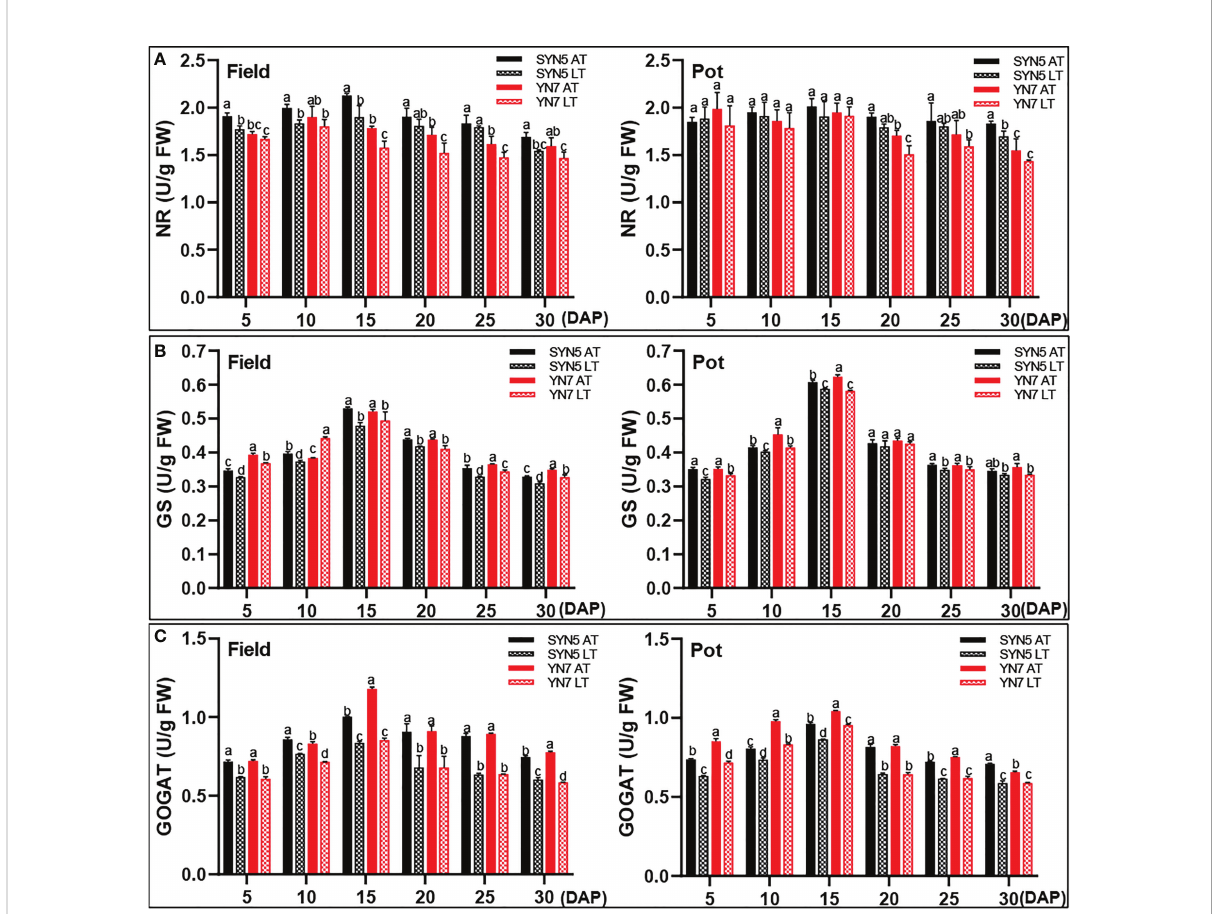
FIGURE 5 Effect of post-silking LT on the enzymatic activities of protein synthase in grains during grain fi lling stage. (A) , GS (glutamine synthetase); (B) , GOGAT (glutamate synthase); (C) , NR (nitrate reductase). Error bars denote standard errors from three replicates, and different letters above the bars in same sampling date are signi fi cantly different at P <